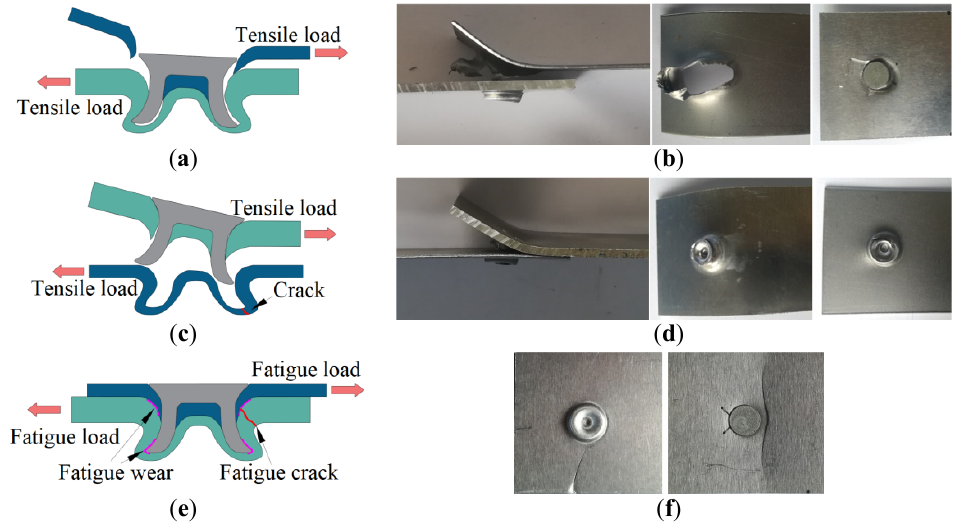
Figure 3. ( a ) Tensile failure mode of SA joint; ( b ) tensile failures of SA joint; ( c ) tensile failure mode of AS joint; ( d ) tensile failures of AS joint; ( e ) fatigue failure mode; ( f ) fatigue failures of joints.